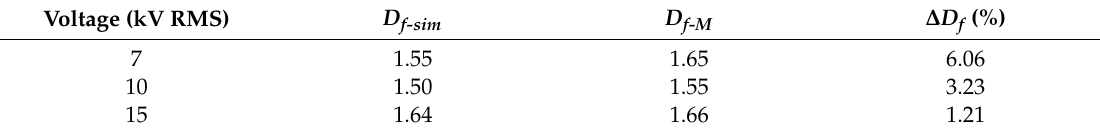
Table 3. Fractal dimension results. D f-sim , simulated; D f-M , measured. Measured values from [22].